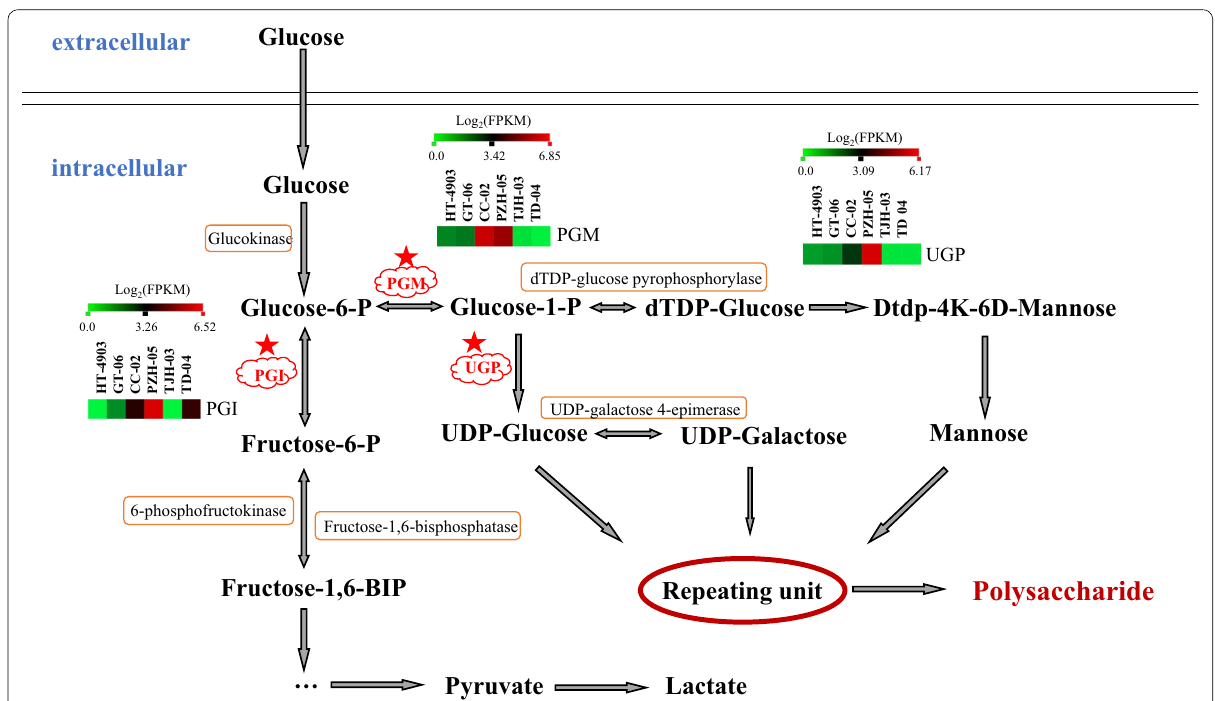
Fig. 6 Putative pathway for intercellular polysaccharide biosynthesis in H. erinaceus . The red stars indicate the three most important enzymes involved in